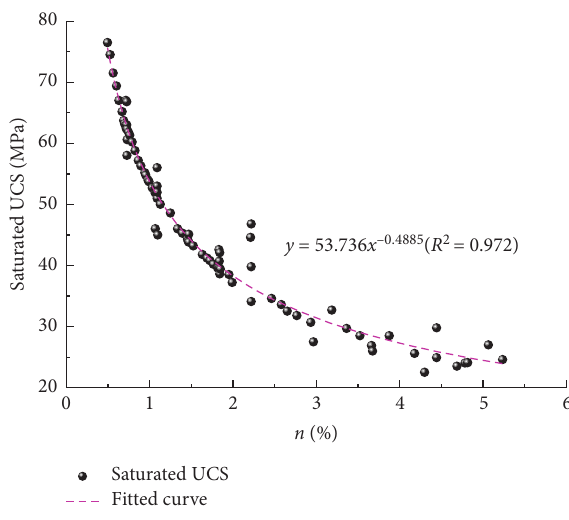
Figure 2: The relationship between the UCS and the porosity ( n � 0 ∼ 0.5%).